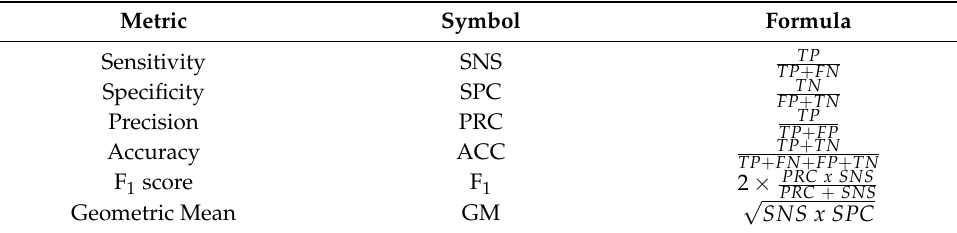
Table 5. Performance metrics.